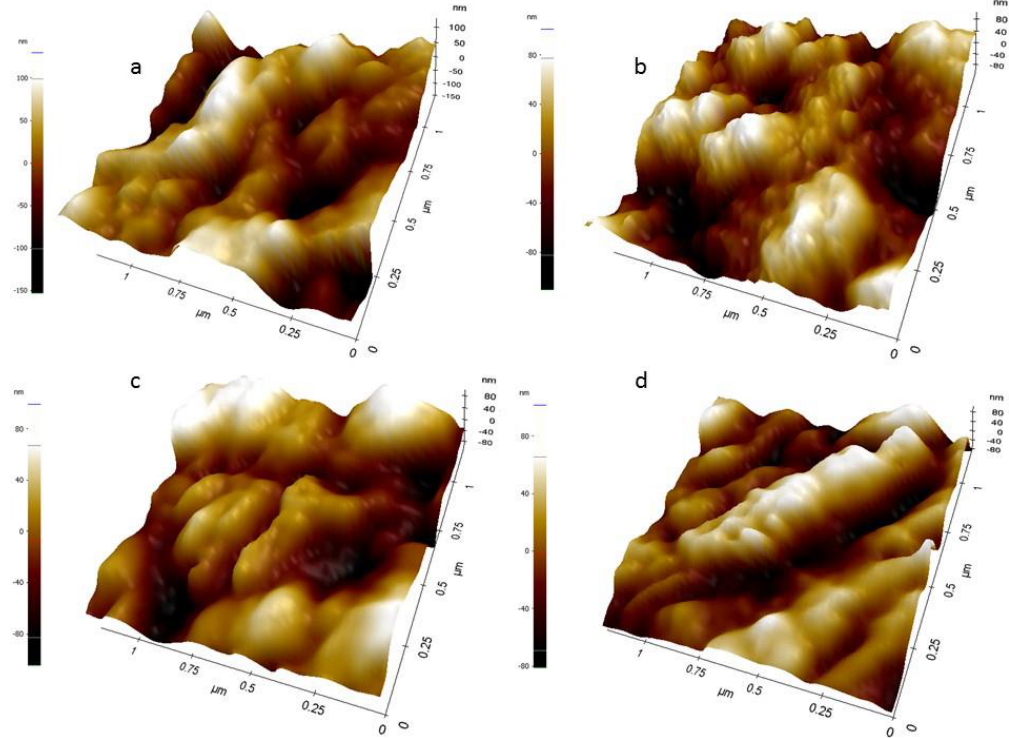
Figure 3. Tapping mode atomic force microscopy (AFM) images of bare-SPCE ( a ); MWNT-SPCE ( b